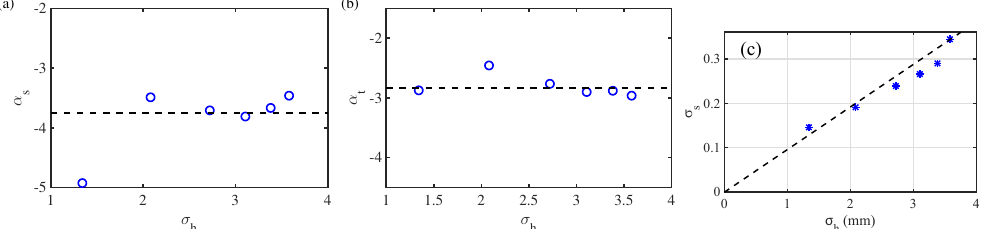
Figure 17. ( a ) S η ( k ) -exponents α s vs. σ h (fits from 0.094 ≤ λ − 1 ≤ 0.30 mm − 1 ). Dashed line shows the theoretical value − 15/4. ( b ) S η ( f ) -exponents α t vs. σ h (fits from 20 ≤ f ≤ 100Hz). Dashed line shows the theoretical value − 17/6. ( c ) Typical wave steepness σ s versus the typical wave amplitude σ h . The dashed line depicts the usual estimation of steepness by σ h k , with k being the wavenumber obtained with the linear dispersion relation for f = 5Hz (central forcing frequency). (Reprinted with permission from [71] Copyright 2022 Cambridge University